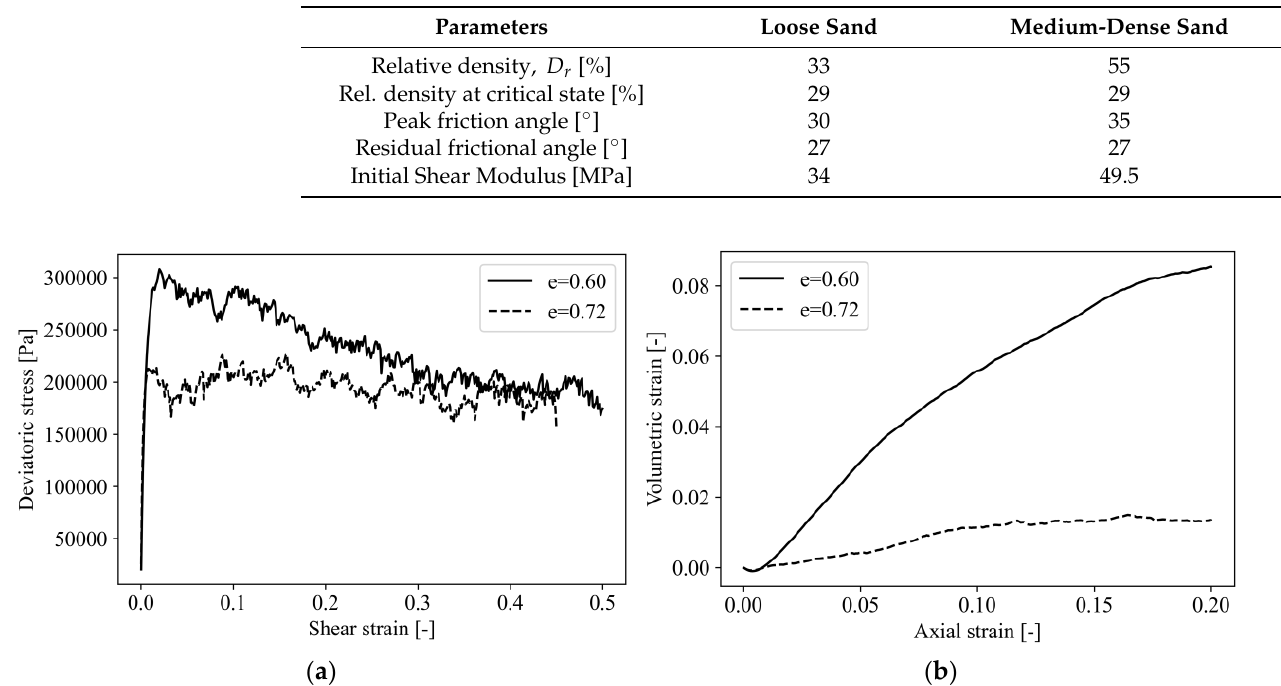
Figure 3. Results of the numerical drained triaxial testing for the loose and medium-dense soil specimens: ( a ) stress–strain curve; ( b ) volumetric strain behavior.